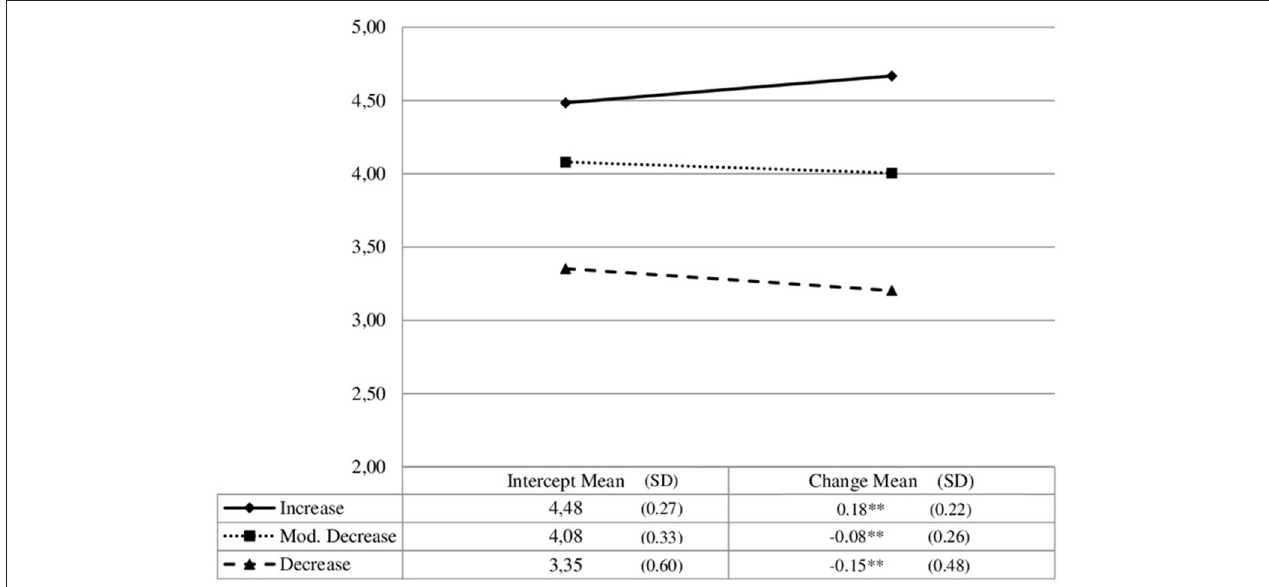
FIGURE 1 | Development of intrinsic motivation (raw scores means). ** p < 0.01.